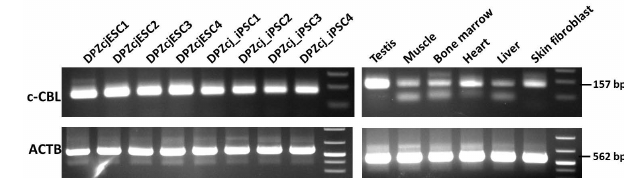
Figure 7. RT-PCR isoform analysis of c-CBL transcripts. The cell lines, testis and cultured fibroblasts exclusively express the larger isoform represented by the 157bp band, which includes the 30nt (nucleotide) variant sequence in exon 1 encoding a poly histidine stretch. The lower band appearing in muscle, bone marrow and liver may indicate the presence of the isoform lacking the 30nt stretch. Beta-actin served as positive control. The gel of the RT-PCR neg- ative controls (-RT, minus reverse transcriptase control) was com- pletely blank (not shown).